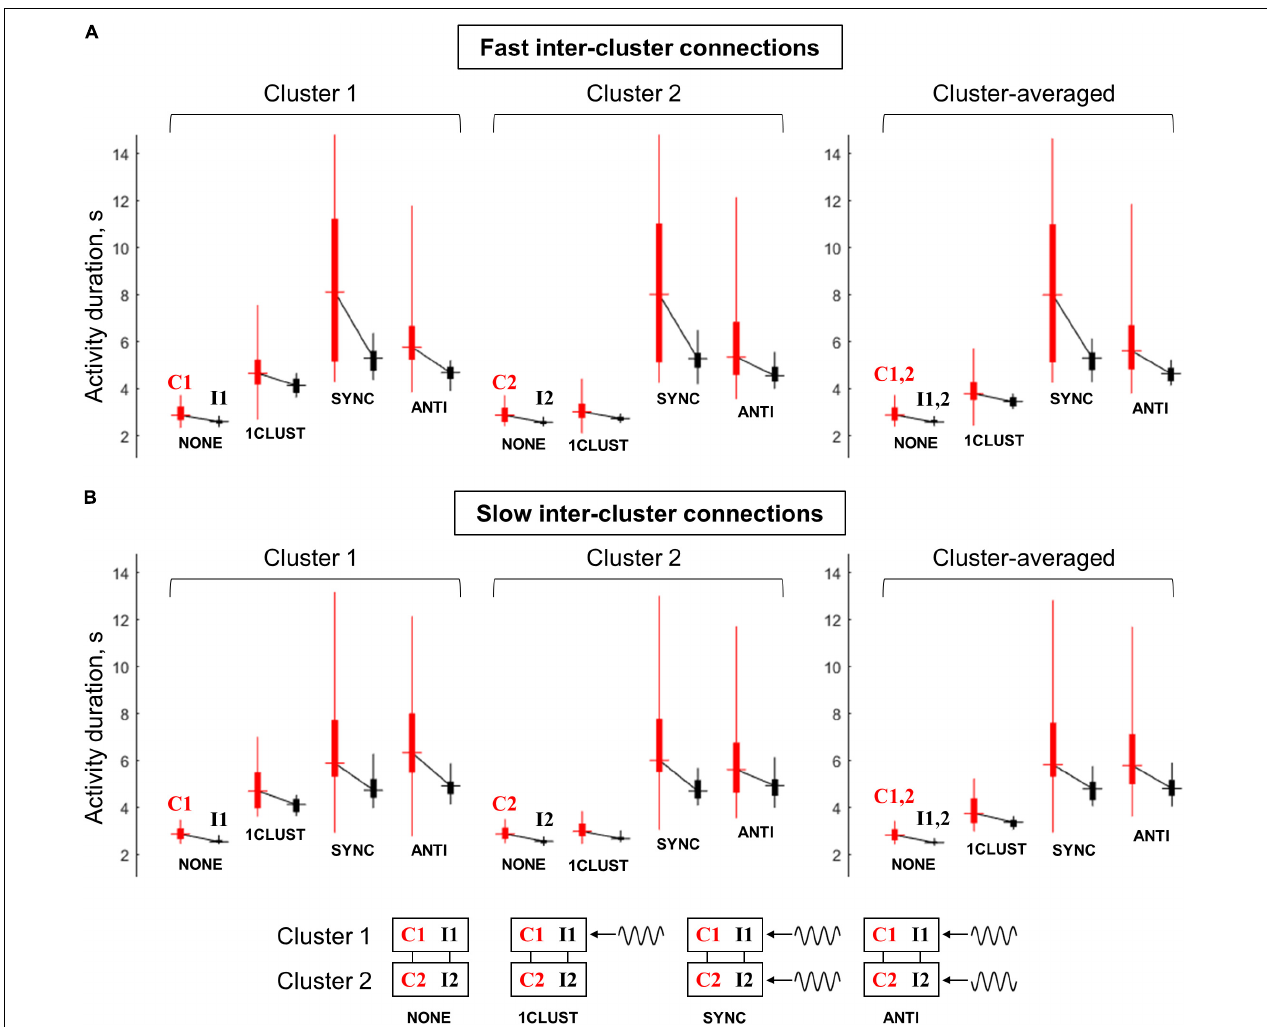
FIGURE 7 | Duration of post-stimulus activity for various circuit groups in the multi-circuit model, depending on the type of oscillatory input. (A) The model with fast inter-cluster connections, (B) the model with slow inter-cluster connections. The connected pairs of red and black vertical bars correspond to pairs of circuit groups within the same cluster. Red bars correspond to the groups that receive a common noise input (C1 and C2), black bars – to the groups that receive independent noise inputs (I1 and I2). Each bar represents statistics of group-averaged post-stimulus activity durations (obtained in 25 simulation runs): horizontal dash – the median, thick vertical line – two middle quartiles, thin vertical line – range between the minimal and maximal values. Left panel: cluster 1 (groups C1, I1), middle panel: cluster 2 (groups C2 and I2), right panel – average over the two clusters (C1+C2 and I1+I2). Four pairs of boxes in each panel correspond to four types of the oscillatory input: NONE – no oscillations, 1CLUST – oscillations are delivered to one cluster only, SYNC – oscillations are delivered to both clusters in the same phase, ANTI – oscillations are delivered to both clusters in the opposite phases (schematic representations on the input types are presented in the bottom part of the figure). It is seen that oscillatory input increases the activity duration, as well as the difference in activity duration between the “common-noise” and “independent-noise” groups; these effects are stronger when oscillations are delivered to both clusters. The effects of the in-phase input are more prominent than of the anti-phase input for the model with fast inter-cluster connections. For the model with slow inter-cluster connections, the in-phase and anti-phase inputs produce the effects of the same